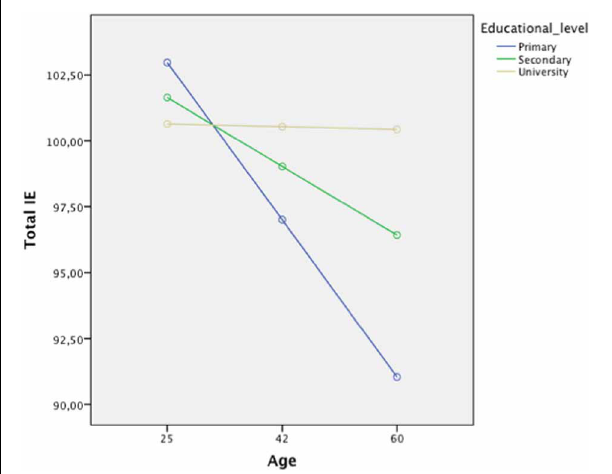
FIGURE 1 | Assessment of the ability of educational level to moderate the association between age and total